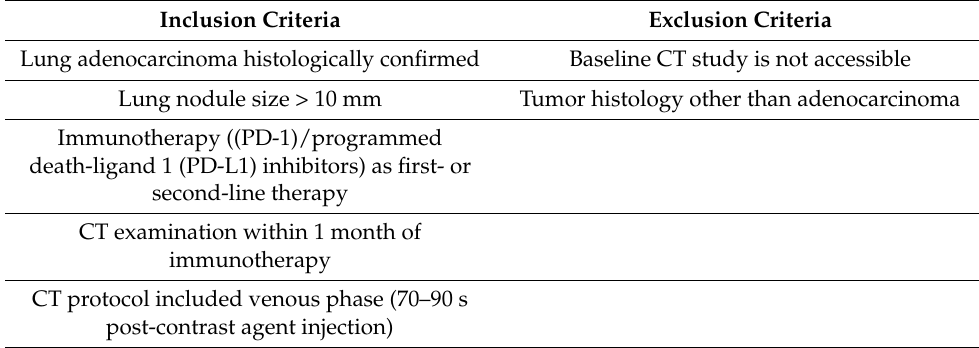
Table 1. Inclusion and exclusion criteria. Inclusion Criteria Exclusion Criteria Lung adenocarcinoma histologically confirmed Baseline CT study is not accessible Lung nodule size > 10 mm Tumor histology other than adenocarcinoma Immunotherapy ((PD-1)/programmed death-ligand 1 (PD-L1) inhibitors) as first- or second-line therapy CT examination within 1 month of immunotherapy CT protocol included venous phase (70–90 s post-contrast agent